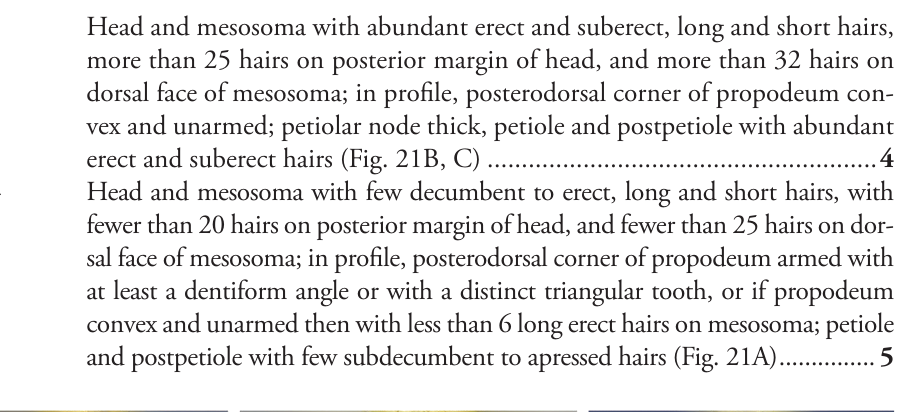
Figure 20. Head in full-face view of A Carebara grandidieri (CASENT0036011) B Carebara creolei (CASENT0060069).